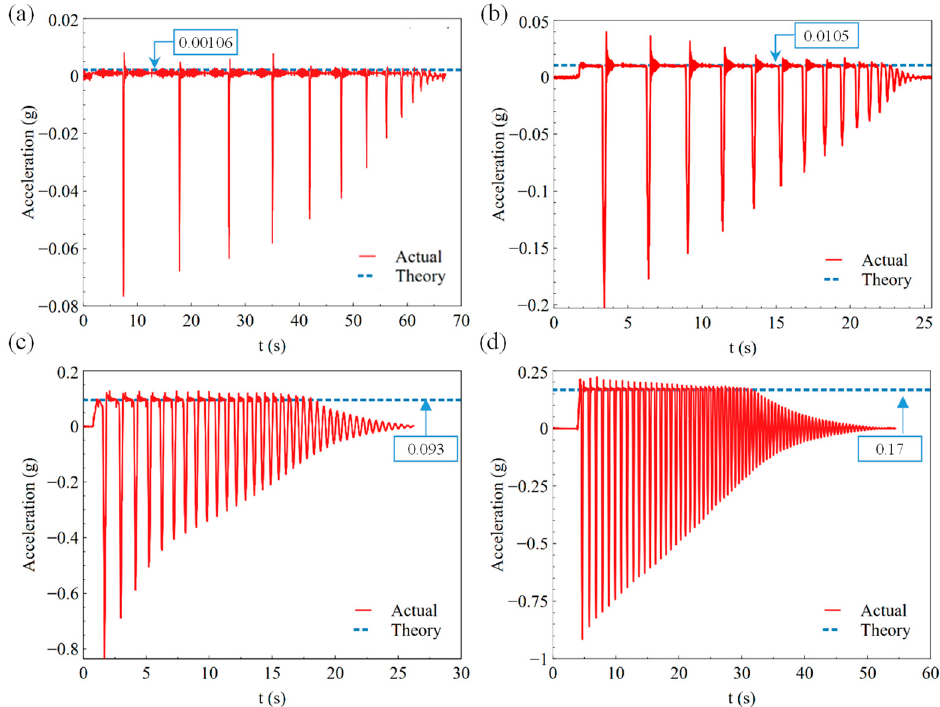
Figure 13. Acceleration of the landing buffer tests with external force of ( a ) 0.98 N, ( b ) 9.8 N, ( c ) 96 N, ( d ) 196 N.